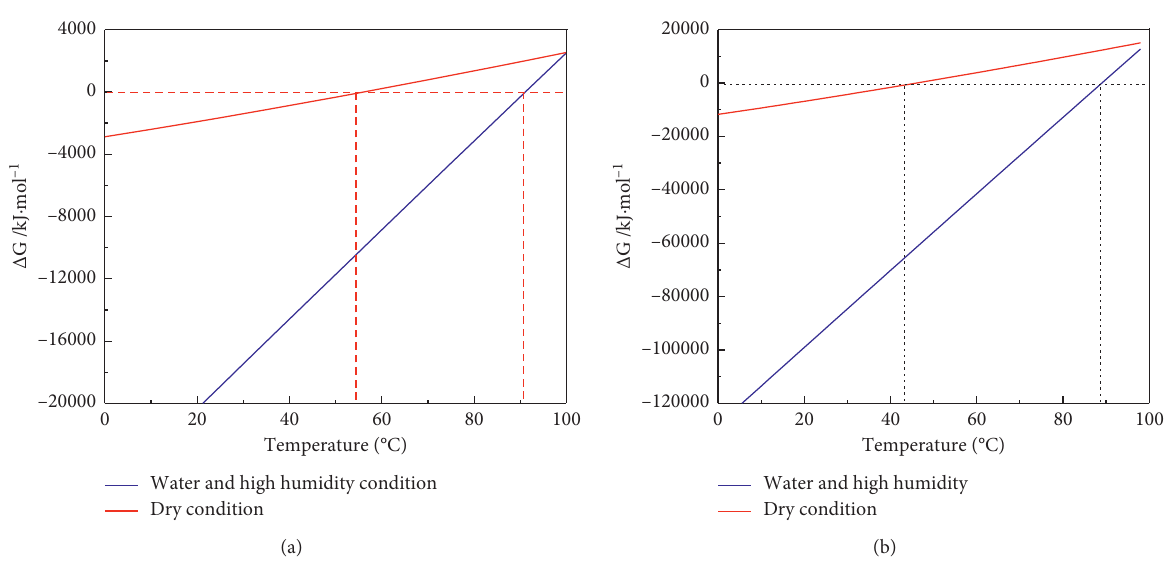
Figure 1: Gibbs free energy of various erosion products under different conditions versus temperature. (a) Dihydrate gypsum and anhydrite. (b) Mirabilite and